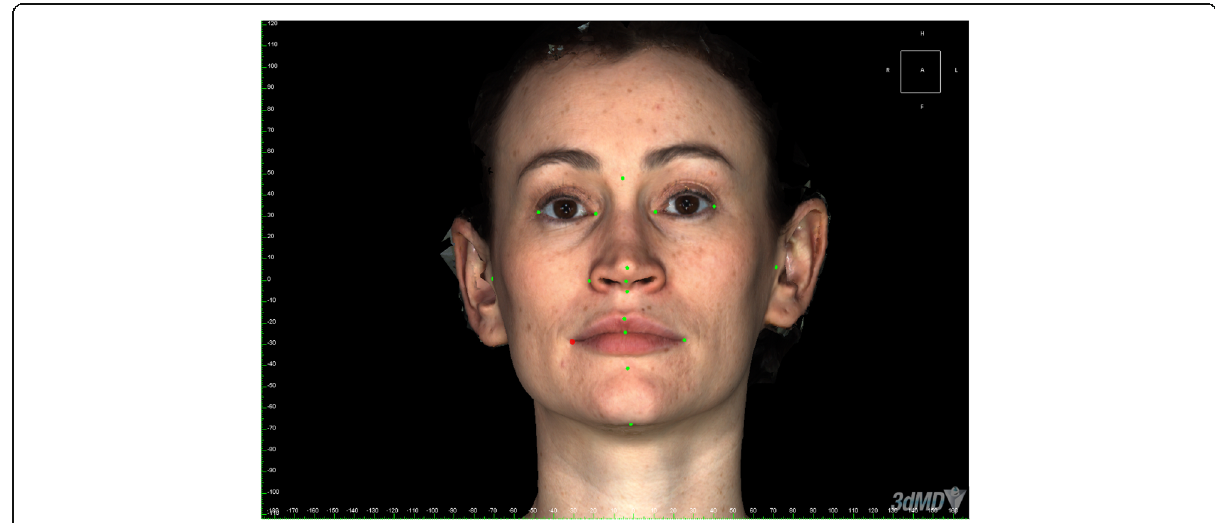
Fig. 1 Example of a captured image; subjects were in natural head position and were asked to tie back long hair